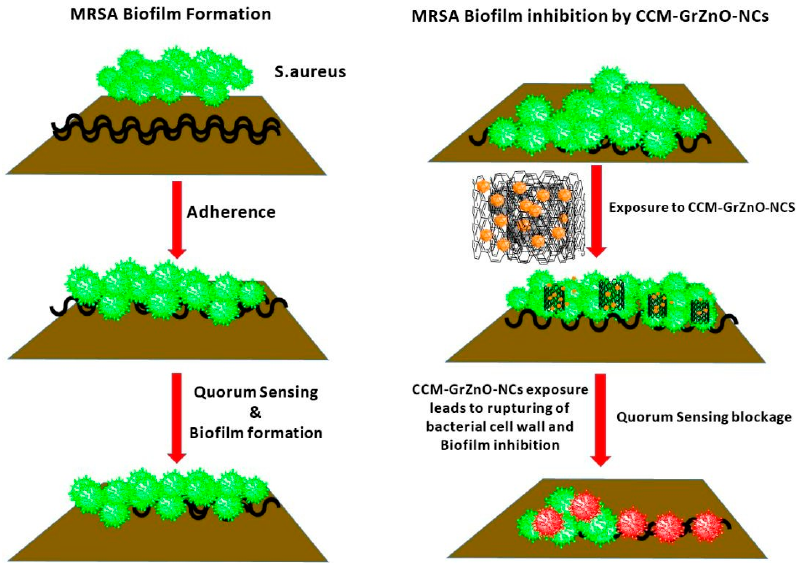
Figure 7. Schematic representation of the proposed mechanism of GrZnO-CCM combination mediated biofilm inhibition and blocking of quorum sensing.